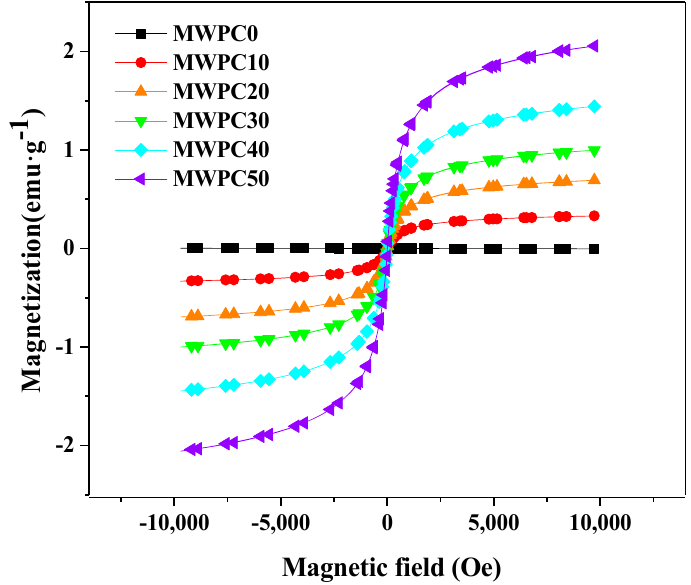
Figure 7. Magnetic hysteresis curves of the magnetic biocomposites.